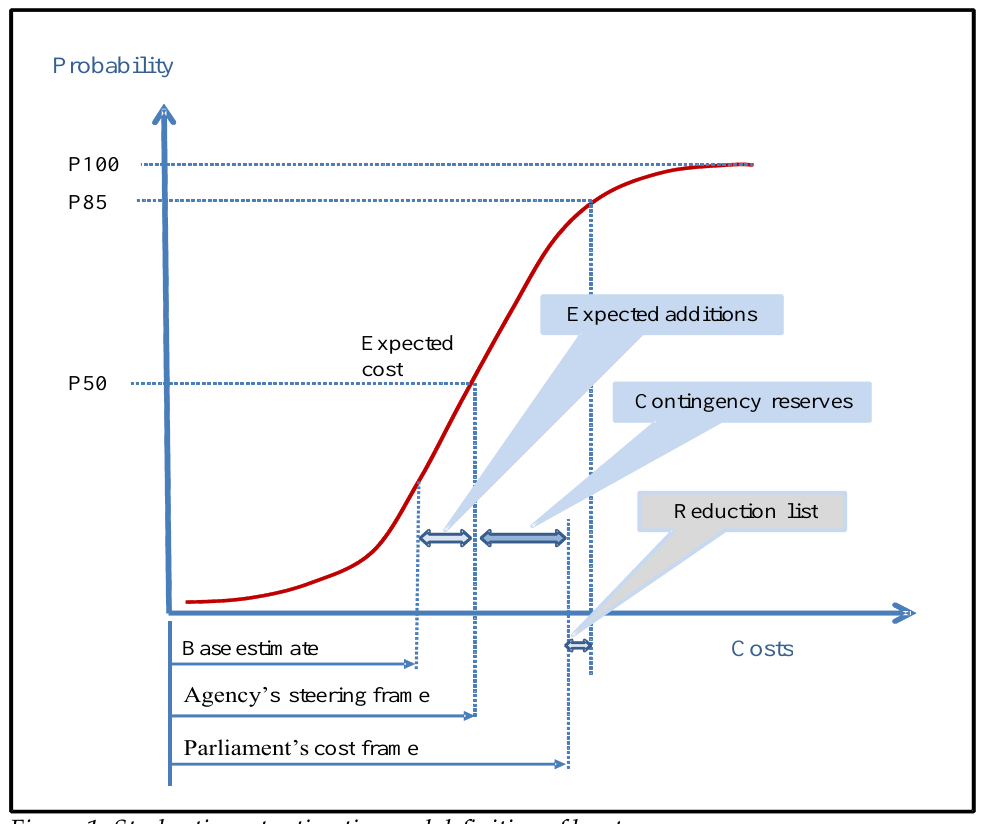
Figure 1. Stochastic cost estimation and definition of key